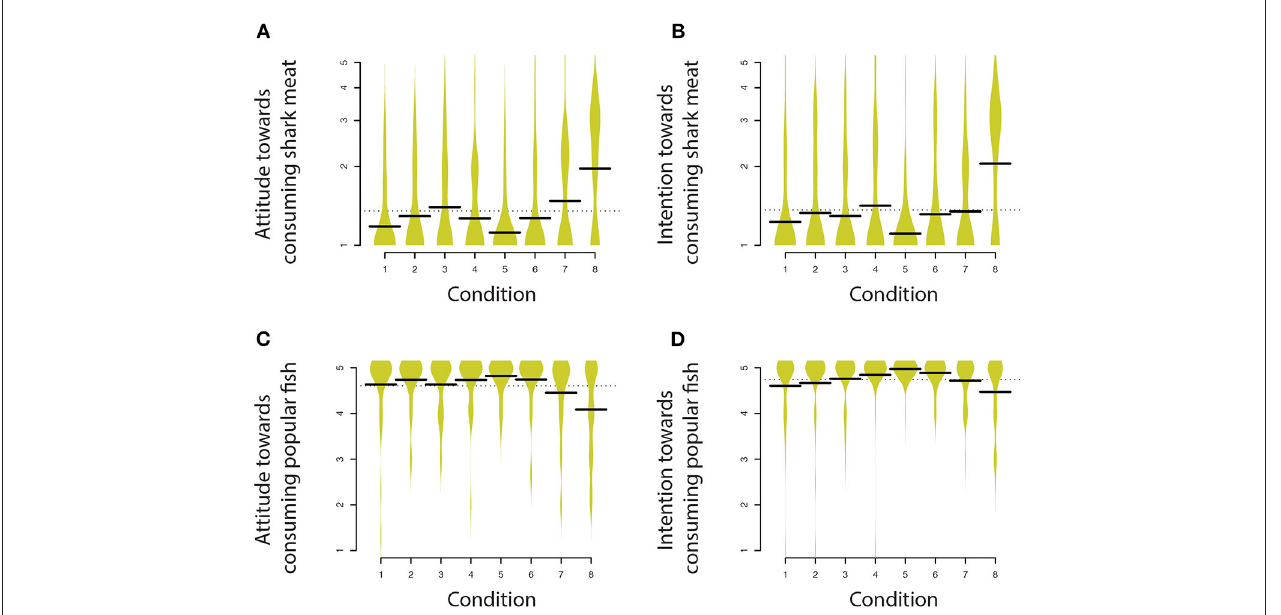
FIGURE 2 | Beanplots of the four outcomes by condition. Each “bean” shows the distribution of participants’ attitudes and intentions. The black lines indicate the mean score for each condition. The dotted lines indicate the overall mean of each outcome. Scales for attitudes range from 1 ( negative/bad/irresponsible ) to 5 ( positive/good/responsible ). Scales for intentions range from 1 ( completely disagree ) to 5 ( completely agree ). (A) Means for attitudes toward consuming shark meat. (B) Means for intentions toward consuming shark meat. (C) Means for attitudes toward consuming popular fish. (D) Means for intentions toward consuming popular fish.